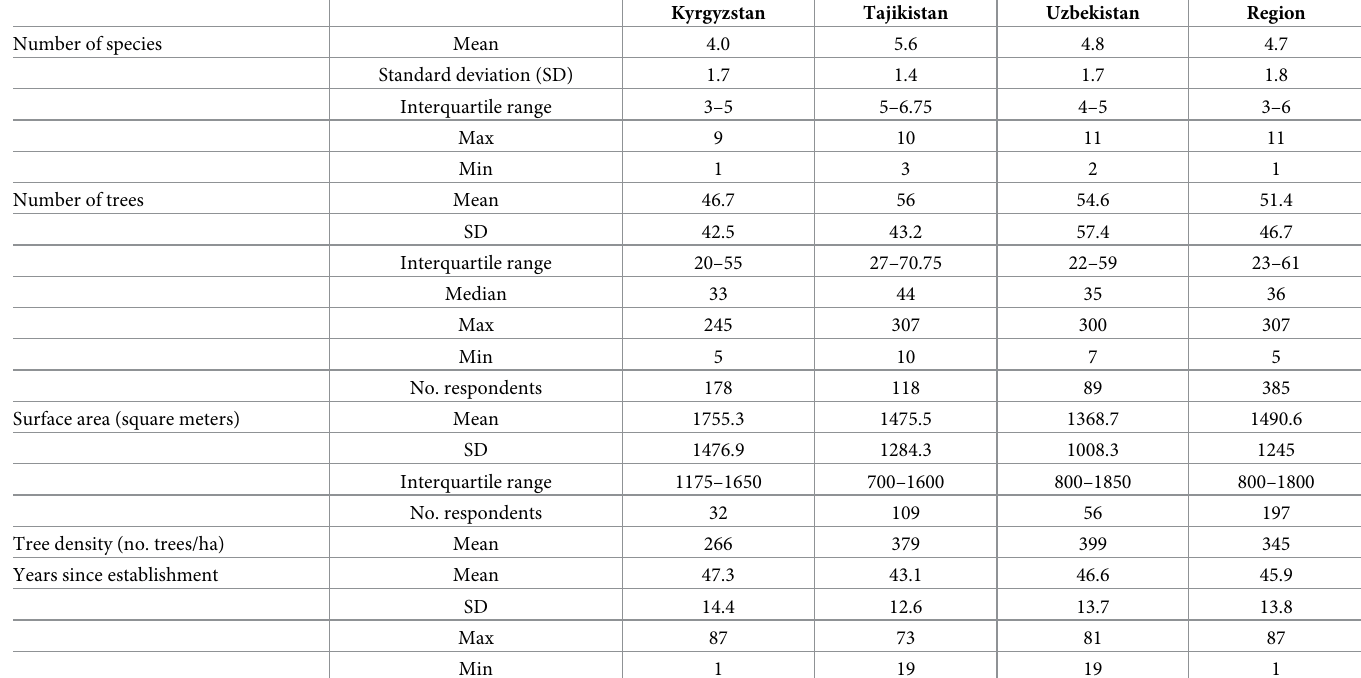
Table 3. Characteristics of home gardens.